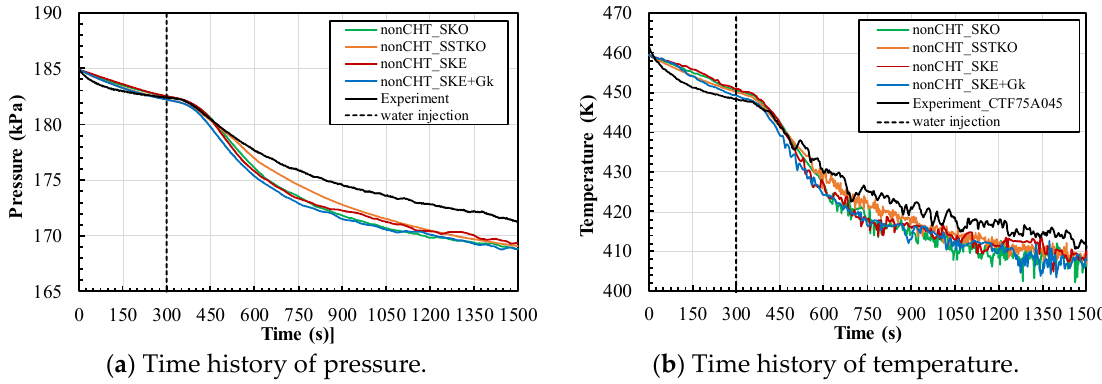
Figure 9. Time history of pressure and temperature as measured (black line) and numerically predicted by means of different turbulence models (colored lines). Table 4. Simulation model deviation from the measurement: effect of turbulence models.